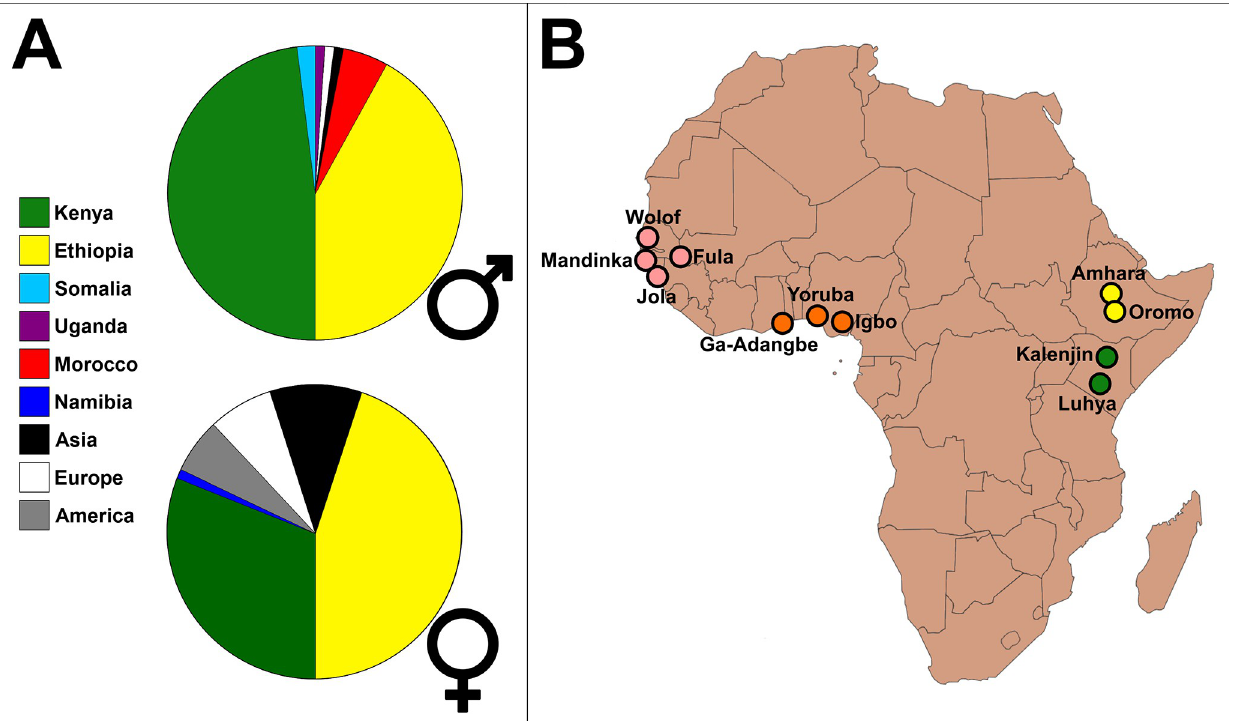
Fig 1. A) Place of birth of the 100 best marathon runners of all time, men and women, as listed by the International Association of Athletics Federations on June 29, 2019. Note the large fraction corresponding to Kenya and Ethiopia, in both sexes. B) Approximate locations for the African ethnolinguistic groups (populations) used in this